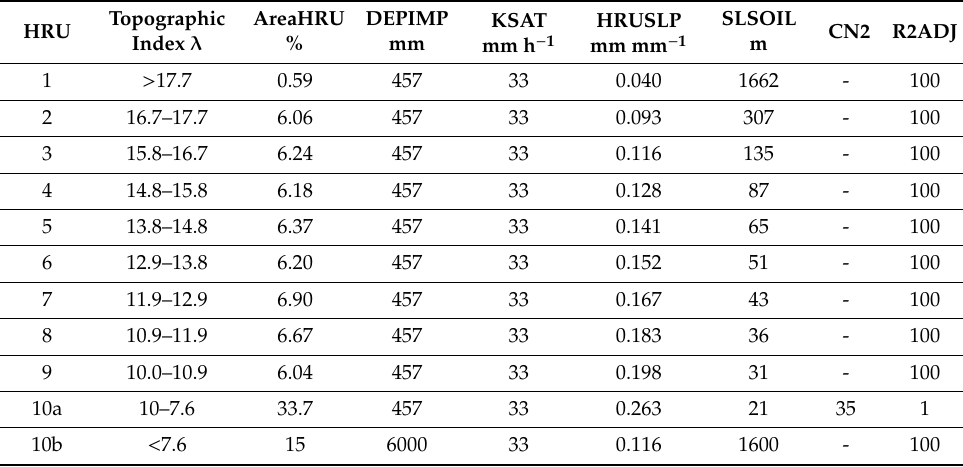
Table 1. Hydrologic response unit (HRU) level parameters for the SWAT-wil model application in Town Brook. DEPIMP is the depth of the impermeable layer, D ; KSAT is the saturated conductivity, K s ; HRUSLP is the slope; SLSOIL is the calculated slope length L wil . R2ADJ a parameter that adjust the SCS curve number runo ff . A value of 100 turns the curve number runo ff to